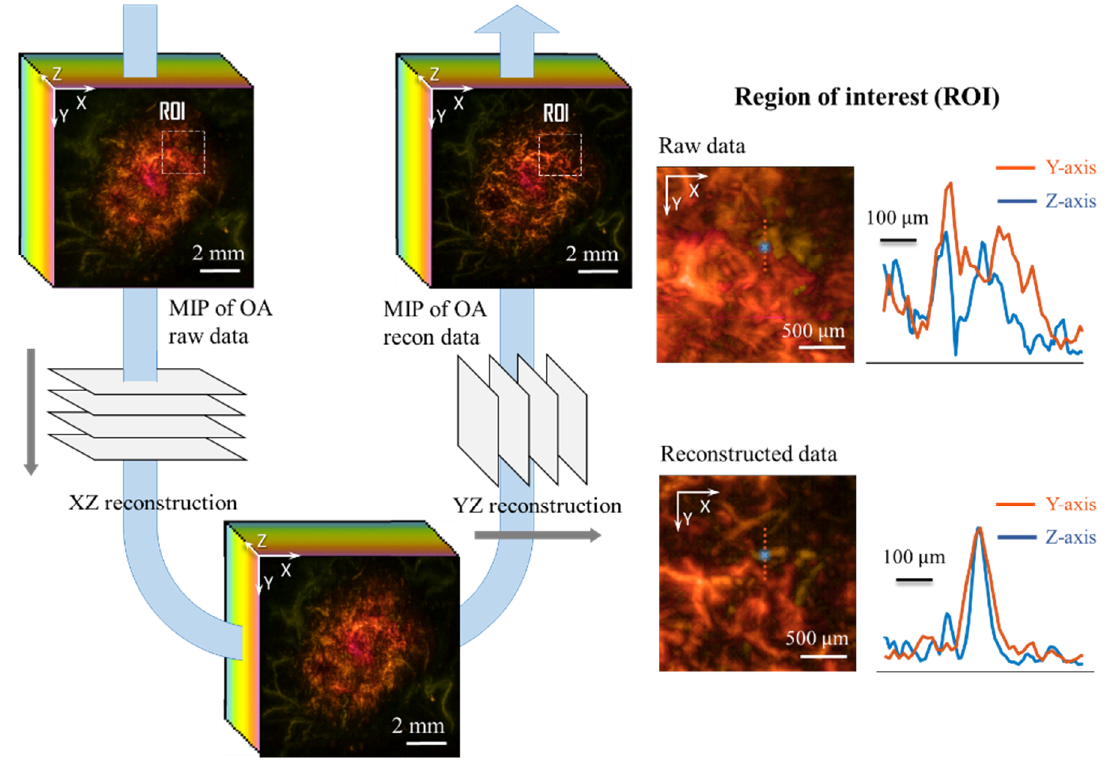
Figure 3. Sequential implementation of GPU-FD algorithm in XZ/YZ planes.